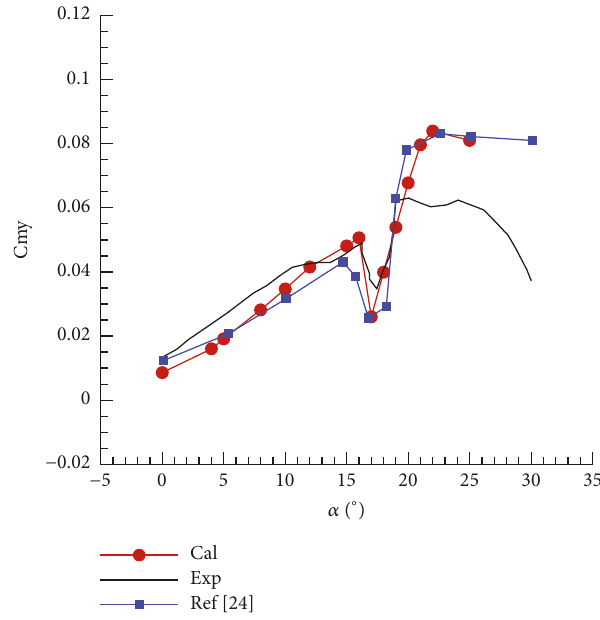
Figure 3: Pitching moment coefficients.